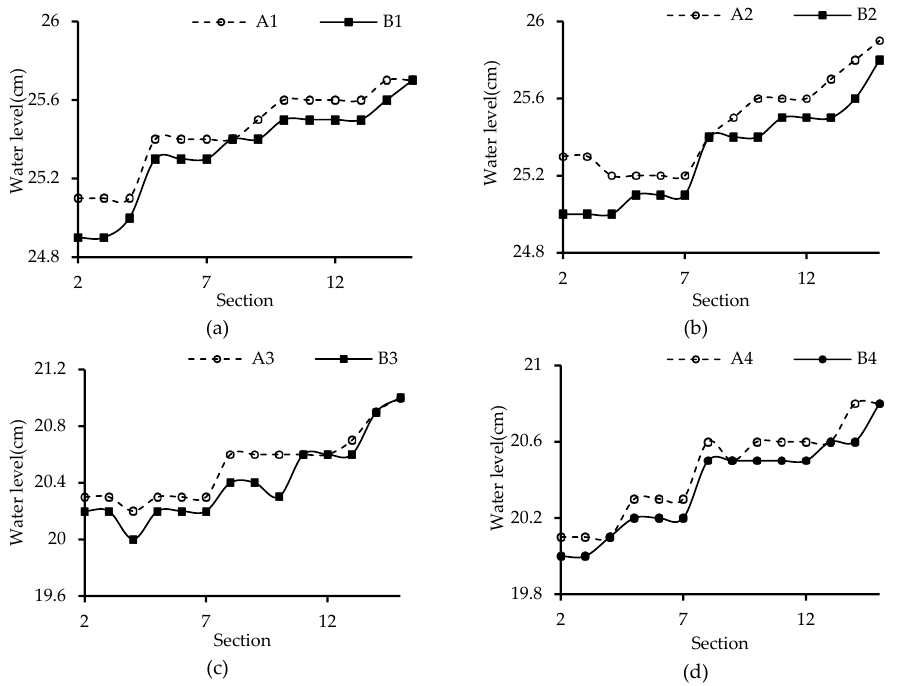
Figure 7. Comparison of water levels in the upstream cross section when the initial ice jam passes the pier (CS-16) with a local scour and those without a local scour. (( a ): H 0 = 0.25 m, V 0 = 0.17 m/s; ( b ): H 0 = 0.25 m, V 0 = 0.15 m/s; ( c ): H 0 = 0.20 m, V 0 = 0.17 m/s; ( d ): H 0 = 0.20 m, V 0 = 0.15